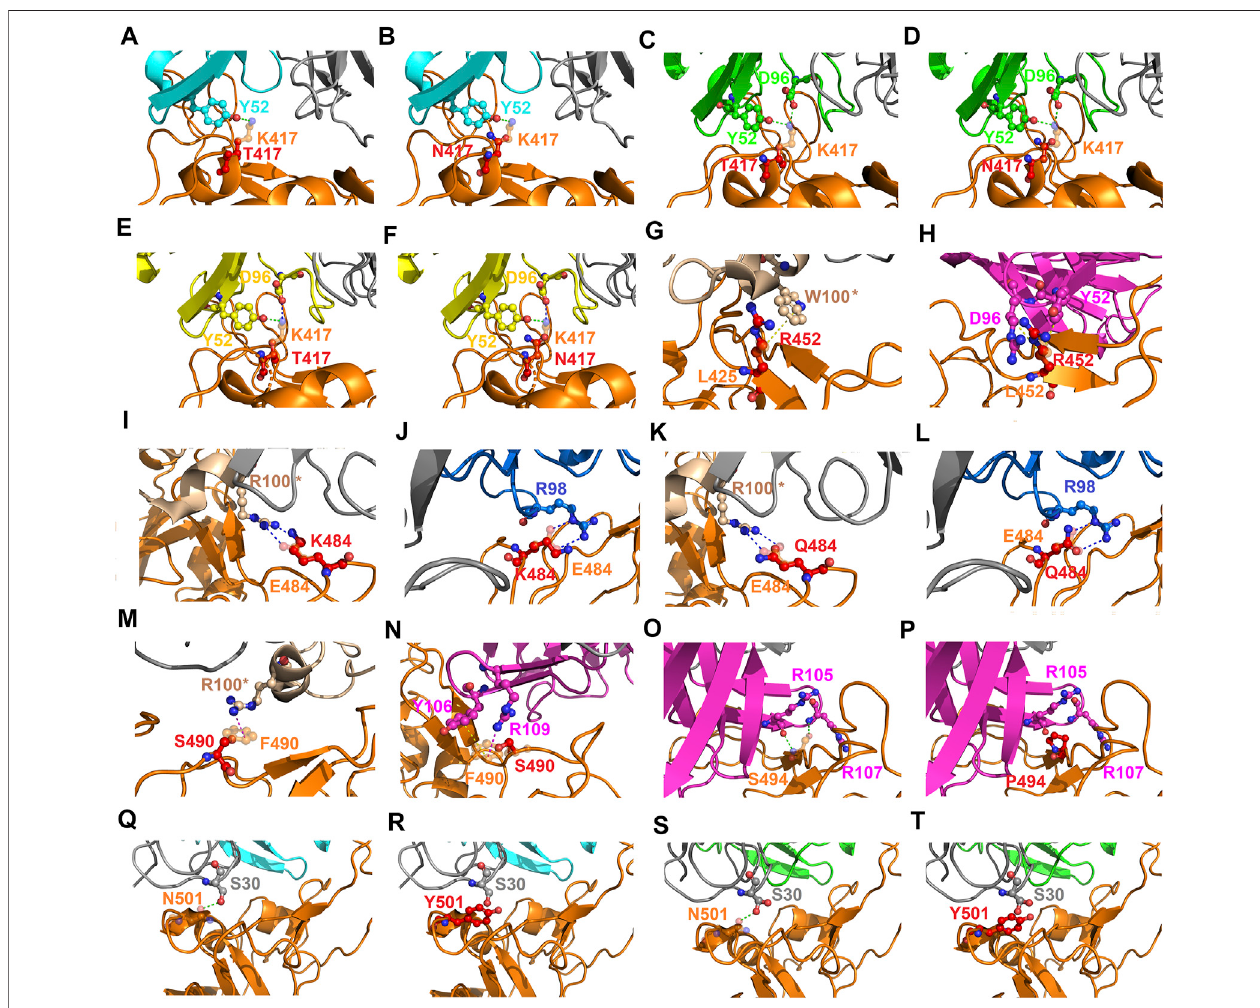
FIGURE 11 | Mutational effects contributing to the modes of action of emerging SARS-CoV-2 RBD variants. (A) An overlapped view of the intermolecular interactions of the B38 antibody to K417 (orange chain) and mutant T417 (red chain) of the RBD. (B) A superimposition of K417 (orange chain) and mutant N417 (red chain)oftheRBDboundwithantibodyB38. (C) ThedistinctinteractionsofK417(orangechain)andmutantT417(redchain)oftheRBDtargetingtheCA1-B12antibody. (D) A superimposition of K417 (orange chain) and mutant N417 (red chain) of the RBD interacting with the CA1-B12 antibody. (E) An overlapped view of K417 (orange chain) and mutant T417 (red chain) of the RBD bound with CA1-B3. (F) A superimposition of K417 (orange chain) and mutant N417 (red chain) of the RBD targeting the CA1-B3 antibody. (G) A comparison of L452 (orange chain) and mutant R452 (red chain) of the RBD binding to the CV07-270 antibody. (H) The distinct interactions of L452 (orange chain) and mutant R452 (red chain) of the RBD targeting the CT-P59 antibody. (I) A superimposed view of E484 (orange chain) and mutant K484 (red chain) of the RBD interacting with the CV07-270 antibody. (J) An overlapped view of E484 (orange chain) and mutant K484 (red chain) of the RBD binding to 47D1. (K) A comparison of E484 (orange chain) and mutant Q484 (red chain) of the RBD in complex with the CV07-270 antibody. (L) The differences between E484 (orangechain)andmutantQ484(redchain)oftheRBDinteractingwiththe47D1antibody. (M) ThedeviationsbetweenF490(orangechain)andmutantS490(redchain) oftheRBDtargetingtheCV07-270antibody. (N) AsuperimpositionofF490(orangechain)andmutantS490(redchain)oftheRBDboundwiththeCT-P59antibody. (O) TheinteractionsofS494(orange chain)and (P) mutantP494(redchain) oftheRBD bindingtotheCT-P59 antibody. (Q) TheinteractionsofN501 (orange chain)and (R) mutant Y501 (red chain) of the RBD targeting the B38 antibody. (S) The interactions of N501 (orange chain) and (T) mutant Y501 (red chain) of the RBD bound to the CA1-B12 antibody. The structures of proteins are presented with ribbons and dashed lines colored green, blue, red, and yellow denoting a hydrogen bond, cation – π interaction, hydrophobic interaction, and electrostatic interaction,